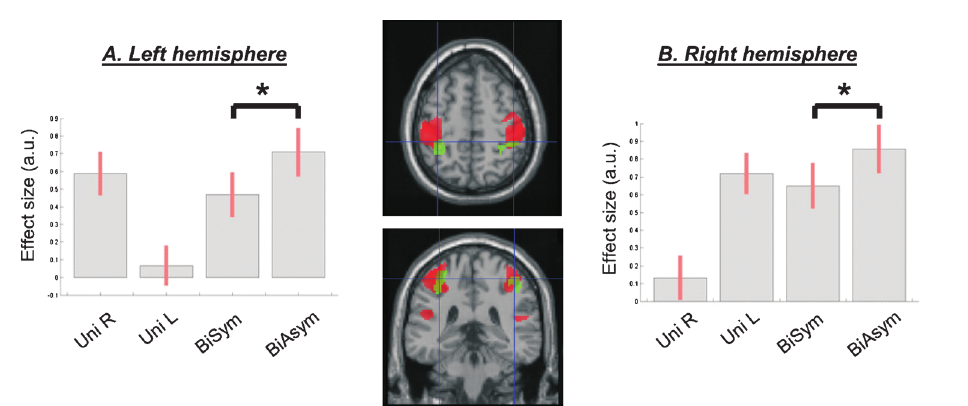
Figure 3. Intra-regional activation for asymmetric bimanual movements. A region at the interception of the anterior intraparietal sulcus and the post-central gyrus (in green) showed greater activation for asymmetric compared to symmetric bimanual passive movements (compare bar 4 vs. 3, in each plot). The